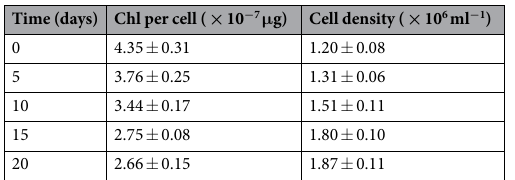
Table 1. The Chl content of P. cruentum cells during nitrogen starvation, and the cell densities in each samples used in PAM measurement (n =